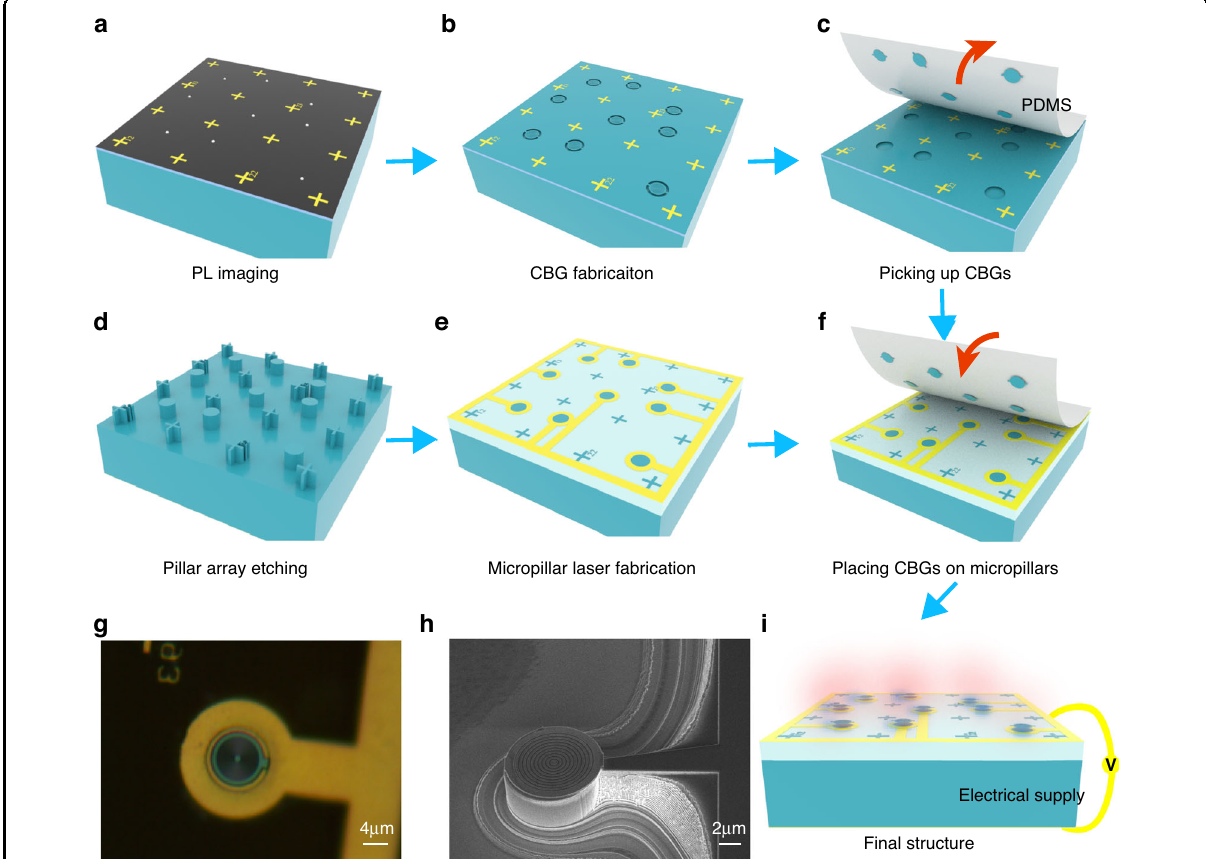
Fig. 3 The device fabrication fl ow. a Preparation of alignment marks and the extractions of QD positions via a PL imaging process. b Deterministically coupled QD-CBG devices fabricated by an aligned E-beam lithography, a dry etch, and a wet etch process. c The CBGs are picked up by attaching and quickly peeling off a transparent rubber stamp. d Fabrication of a micropillar array based on the relative positions of QDs in ( a ). e Fabrication of micropillar laser arrays with electrodes. f Accurately placements of multiple CBGs on top of the micropillar array, resulting in i the fi nal structure. The successful transfer with a high accuracy is supported by the microscope image ( g ) and SEM image ( h